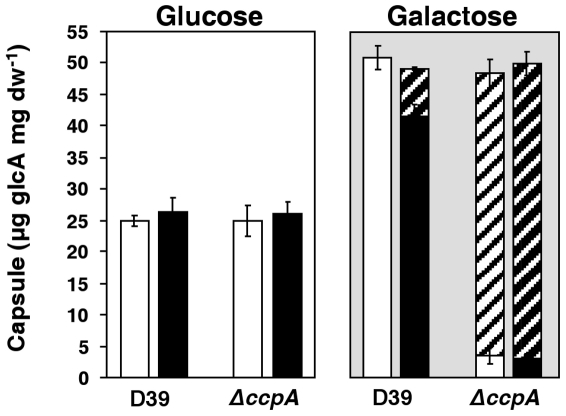
Amount of capsule polysaccharide in D39 and its isogenic ccpA mutant.Estimation of capsule was performed based on the determination of its glucuronic acid content in strains D39 and D39ΔccpA in mid-exponential (white bars, OD600 of 0.35±0.02) and transition-to-stationary (black bars, OD600 of 1.3±0.1) cultures grown in CDM containing 56±1 mM Glc (white background) or 57±1 mM Gal (light grey background). Hatched bars indicate loose capsule polysaccharide. All the determinations were done twice in two independent cultures and the values are means ± SD.